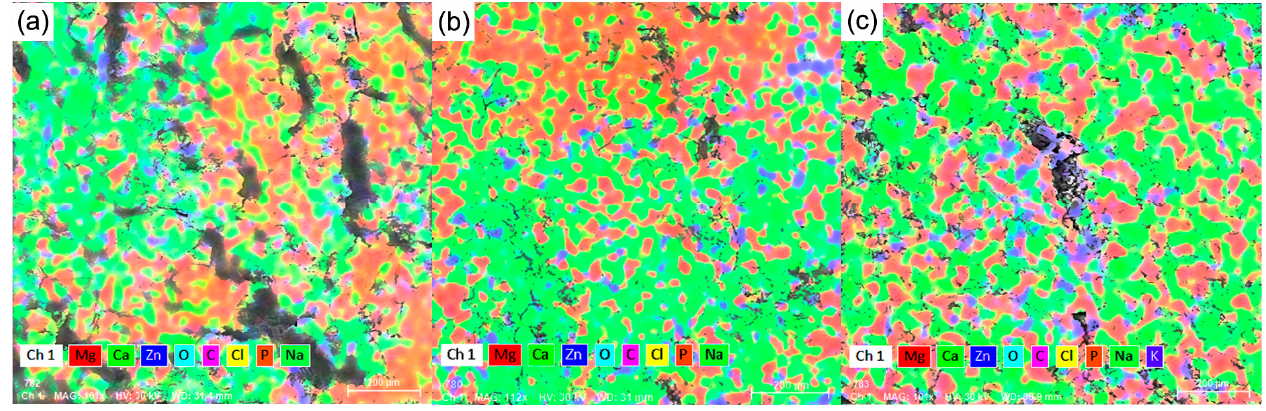
Figure 7. Elemental distribution on the surface after immersion in SBF: ( a ) Mg0.5Ca0.5Zn, ( b ) Mg0.5Ca1.5Zn, and ( c ) Mg0.5Ca3Zn.